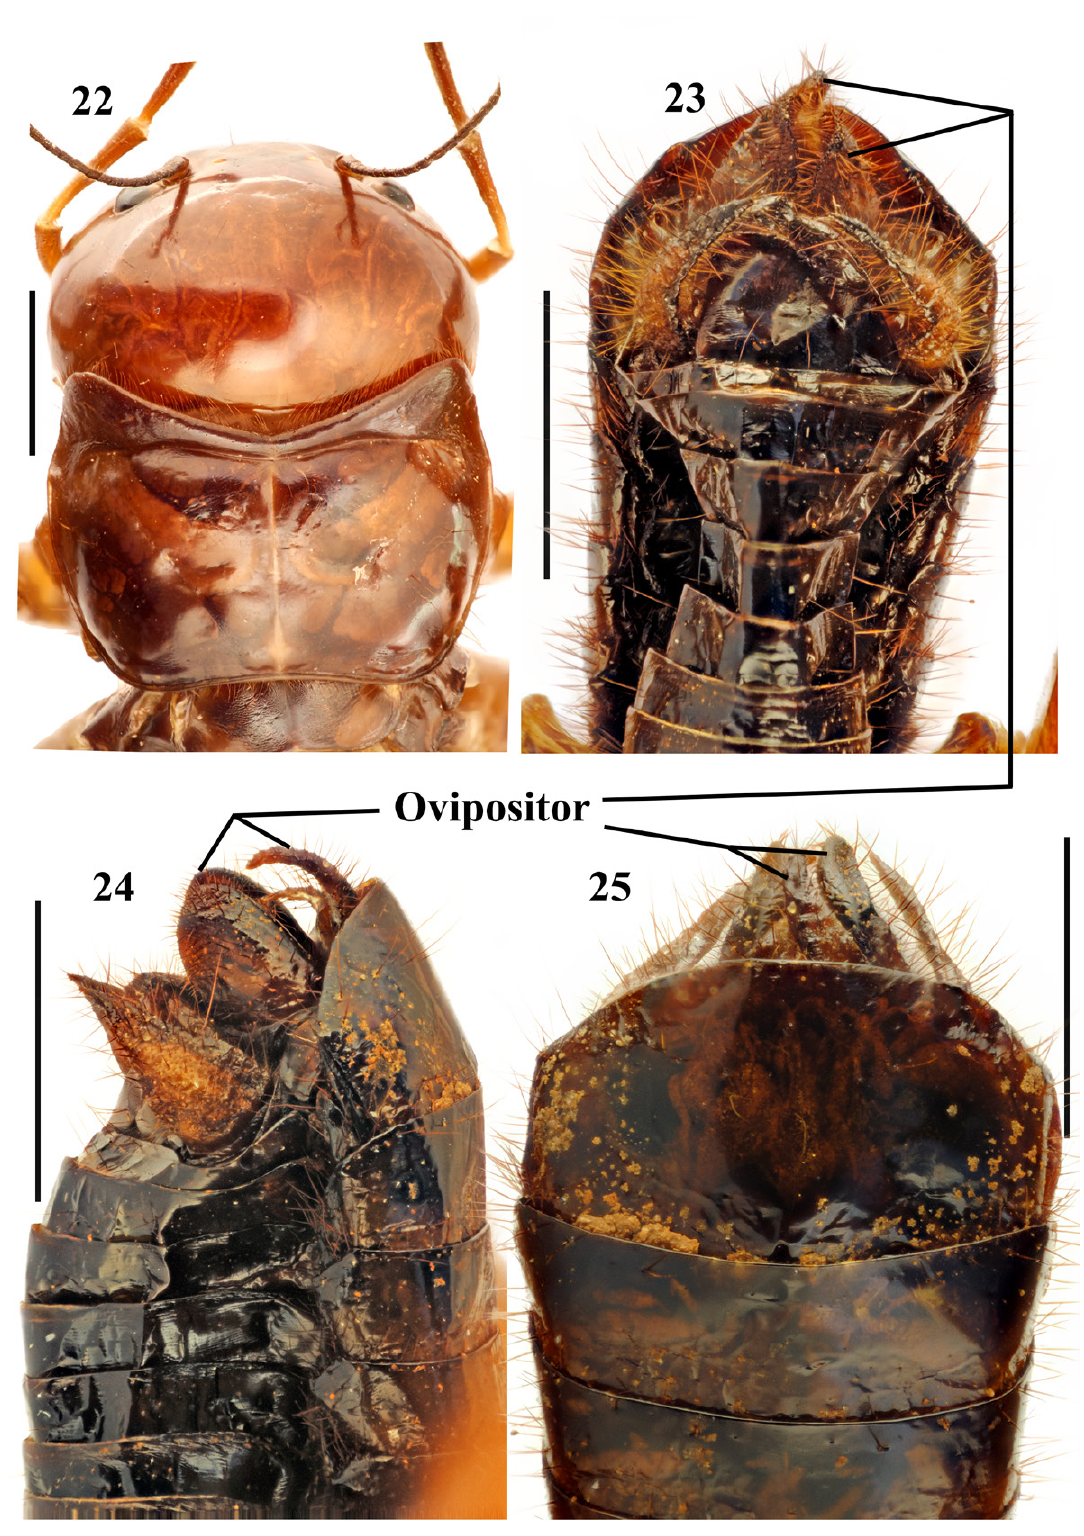
Figs 22–25. Oryctopterus varuna sp. nov. Paratype, ♀ (NBAIR). 22 . Head and pronotum, dorsal view. 23–25 . Apex of abdomen in preserved specimen. 23 . Dorsal view. 24 . Lateral view. 25 . Ventral view. Scale bars = 5